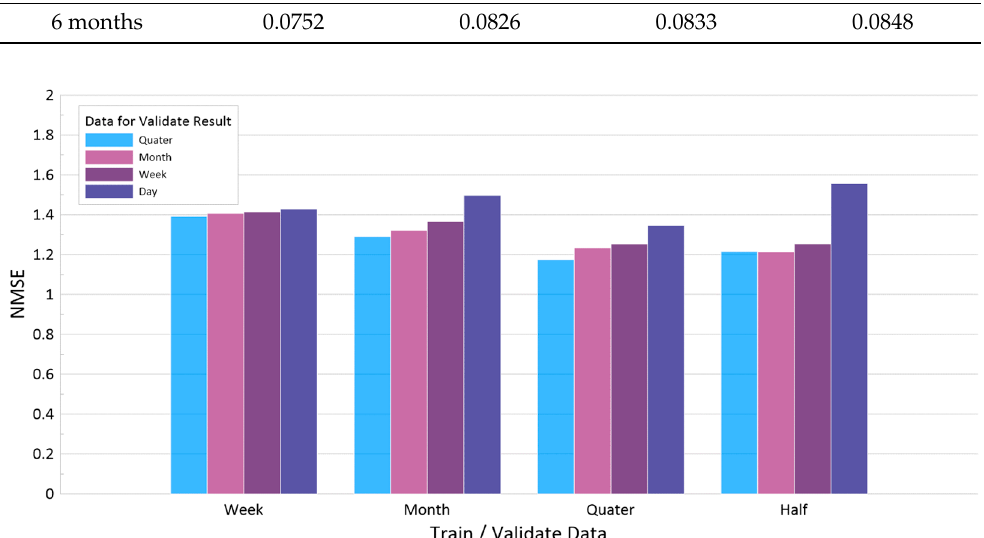
Table 8. Comparison of results with other prediction model.